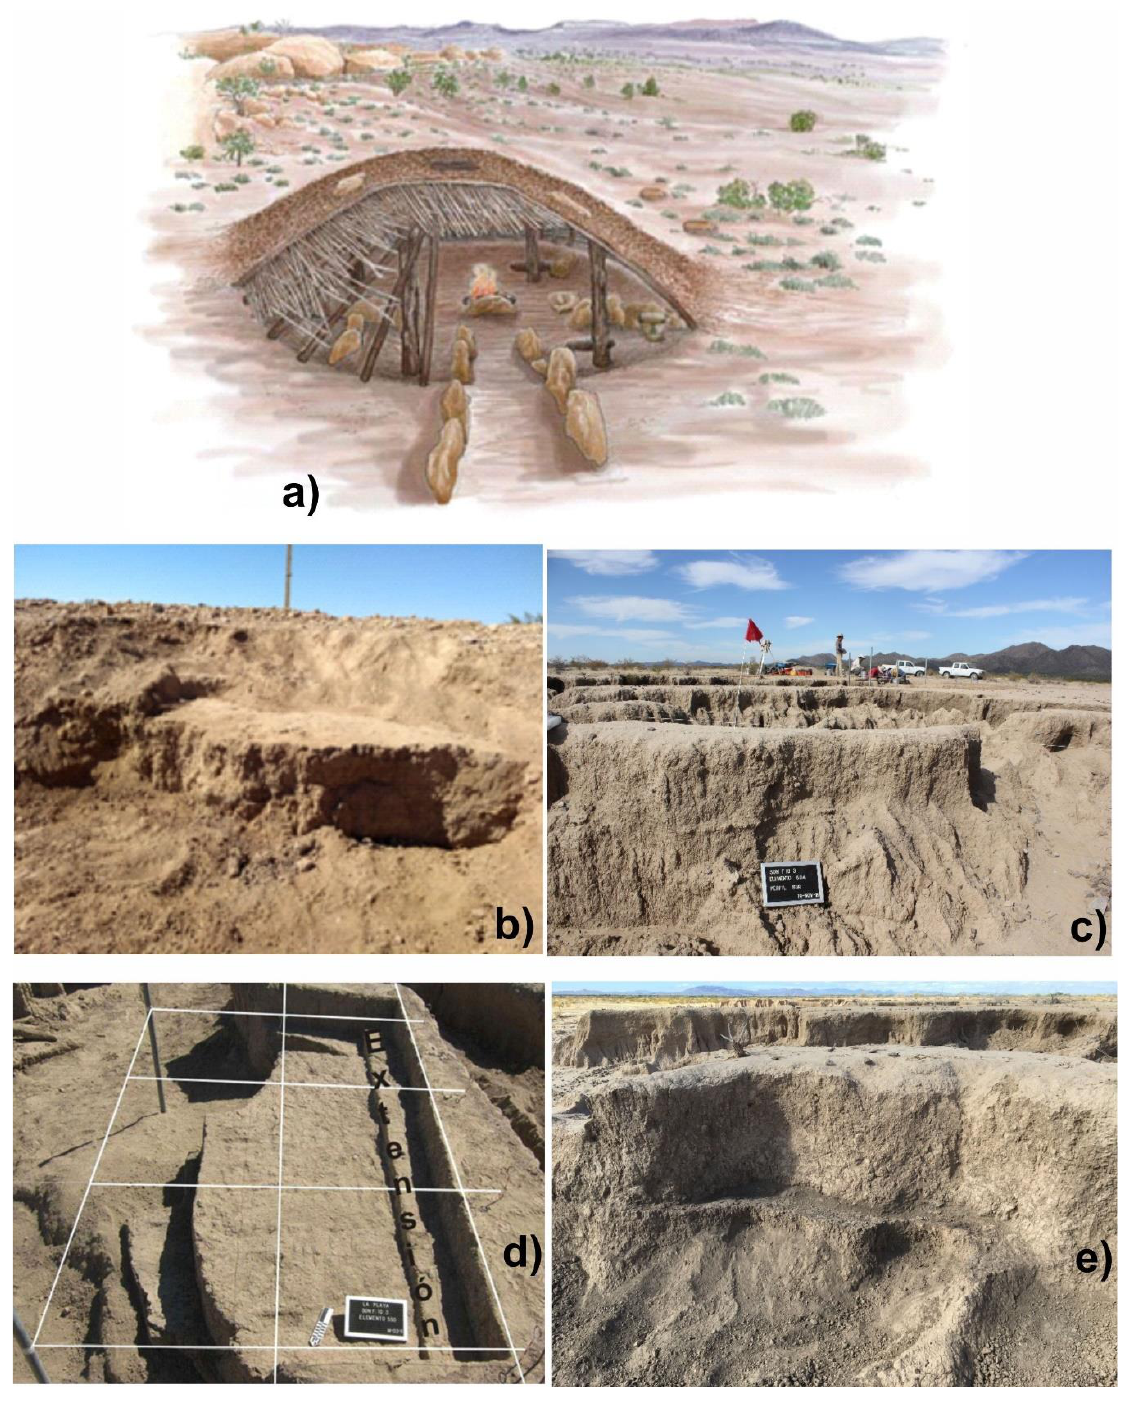
Figure 2. Reconstruction of Pit House, Illustration by Joyce Heuman Kramer; Crow Canyon Ar- chaeological Center (Basketmaker II pithouse (https://www.crowcanyon.org/EducationProducts/ peoples_mesa_verde/basketmaker_II_housing.asp, accessed on 7 January 2023) ( a ) and burned features discovered during the excavations ( b – e ), see text for more